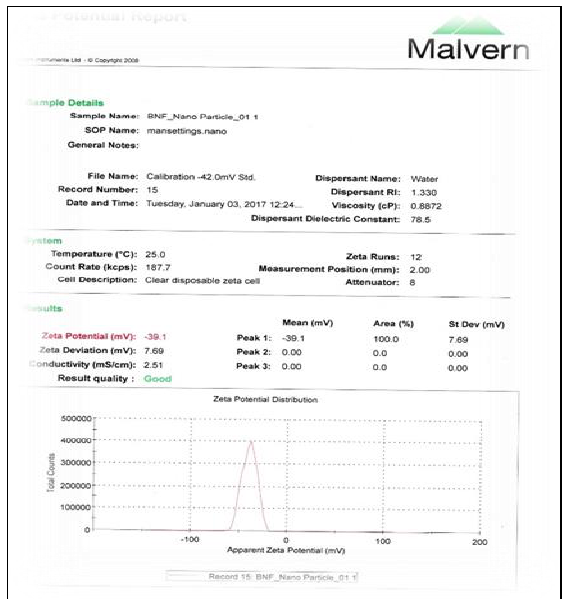
Figure A3. Zeta Potential Report of Nanocellulose.